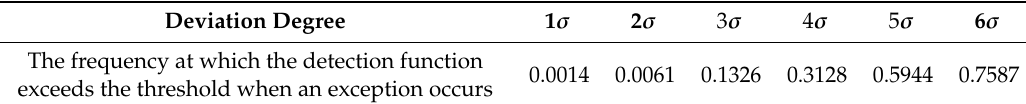
Figure 4. The fault detection functions of different gyro measurement signal. Table 2. The performance test with different anomalies.